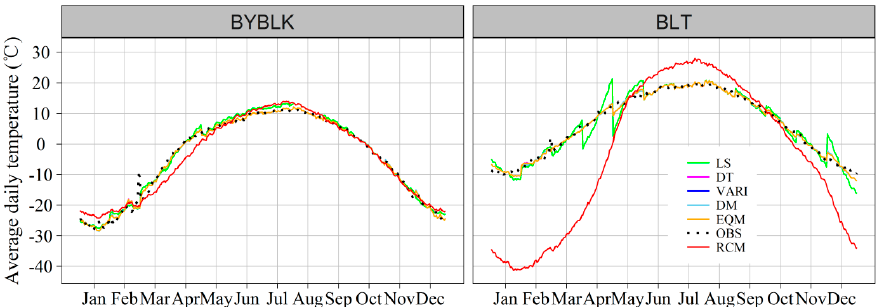
Figure 7. The average daily temperature cycle in the reference period (1965–2004) at BYBLK and BLT meteorological stations.